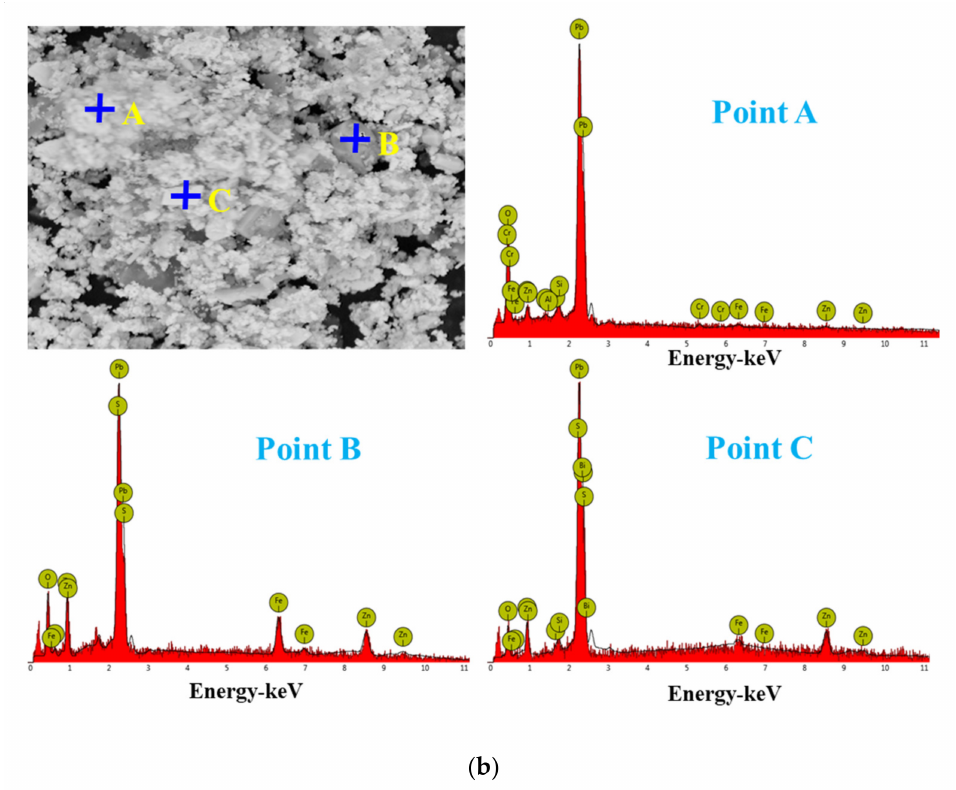
Figure 16. EDS point analysis of the conventional leaching residue ( a ), and the ultrasonic leaching residue ( b ).